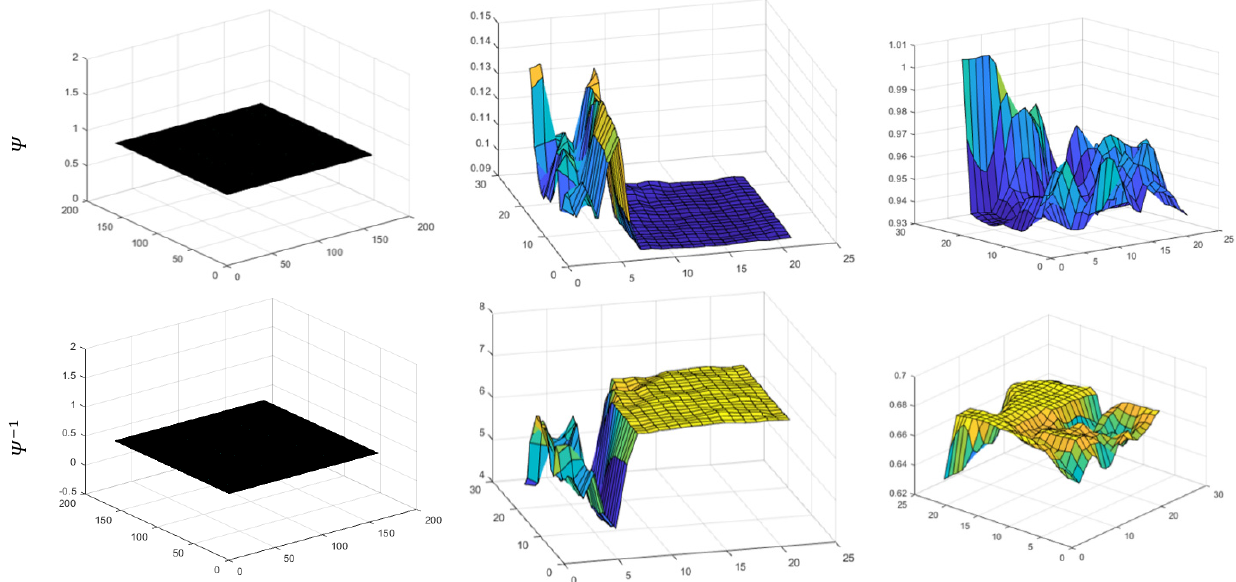
Figure 6. Statistical display of regional edge detection function distribution in RS image.